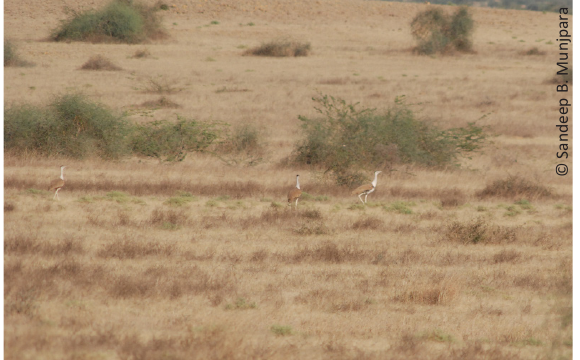
Image 1. Grassland interspersed with scrub